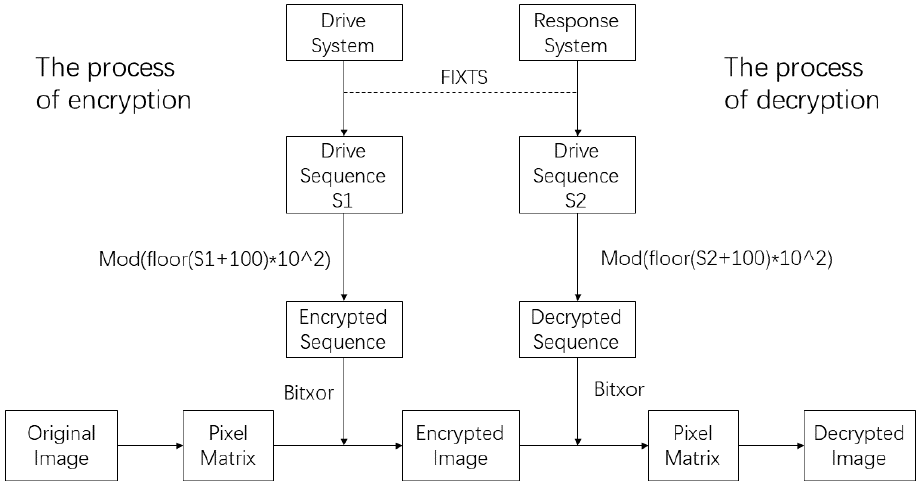
Figure 2. Encryption and decryption process of the proposed